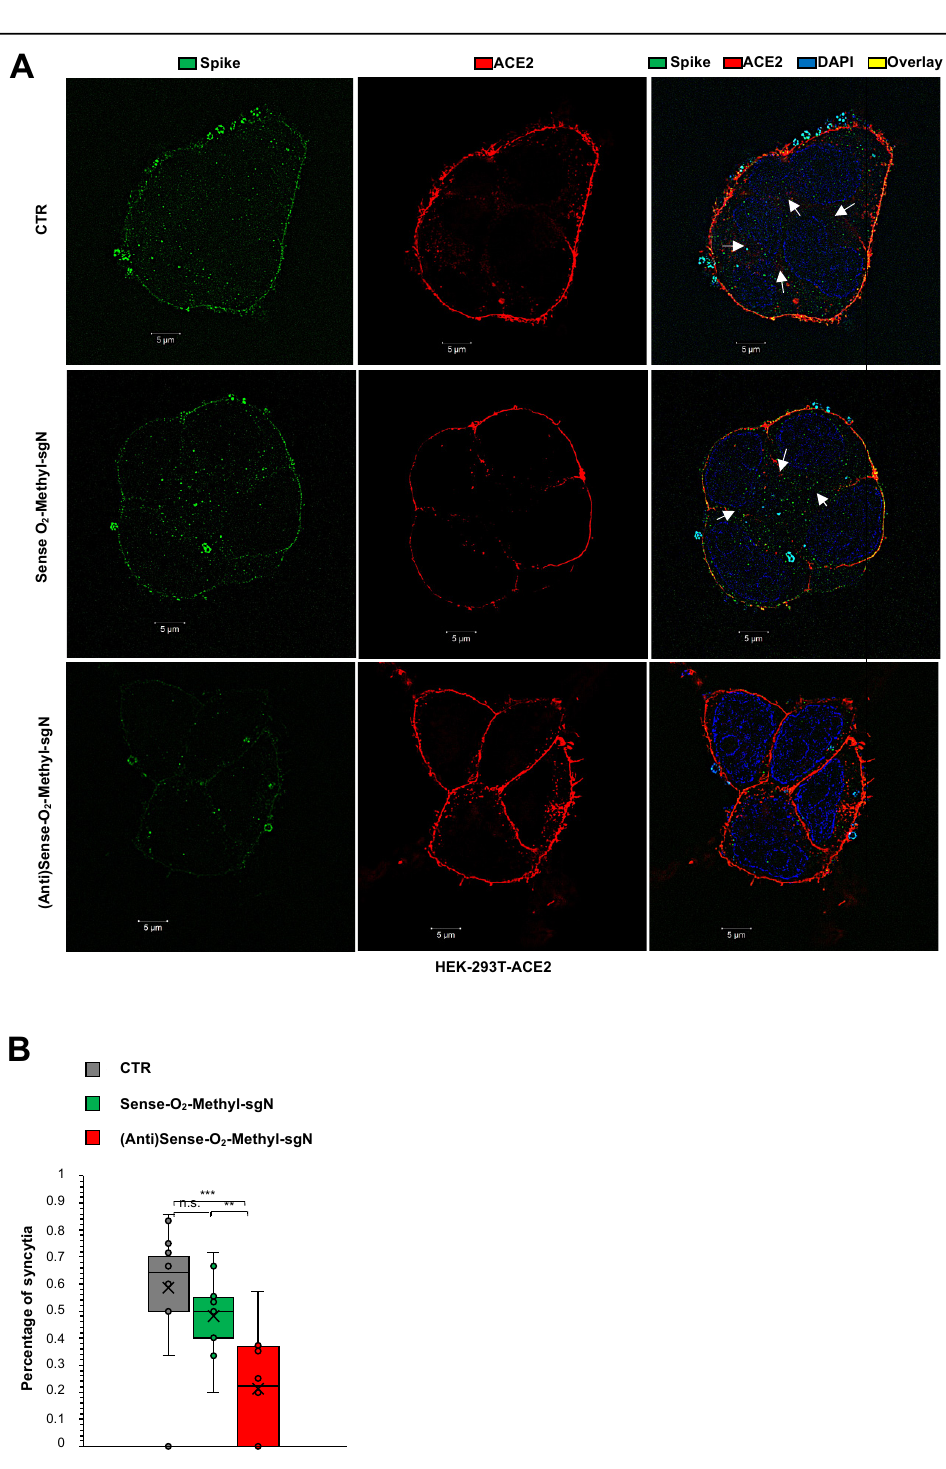
Figure 4. Reduction of syncytia formation by targeting sgN in HEK293T-ACE2 SARS-CoV-2-infected cells. ( A ) Immunofluorescence staining with an antibody against the viral S protein (green) and human ACE2 protein (red) in human HEK-293T cells overexpressing ACE2 transfected with 2’- O - methyl antisense or sense RNA against sgN for 12 h and then infected with 20I/501Y.V1 (B.1.1.7) (UK) (EPI_ISL_736997) SARS-CoV-2 viral particles (MOI, 0.03) for a further 36 h. SARS-CoV-2-infected cells not transfected (CTR) were used as the negative control. Representative images of syncytia. DAPI was used for nuclei. The SIM images were acquired with Elyra 7 and processed with the Zeiss ZEN software (blue edition). Magnification, ×63. Scale bars: 5 μ m. ( B ) Comparison of the proportions (%) of syncytia counted by SIM fluorescence microscopy in human ACE2 (red) proteins